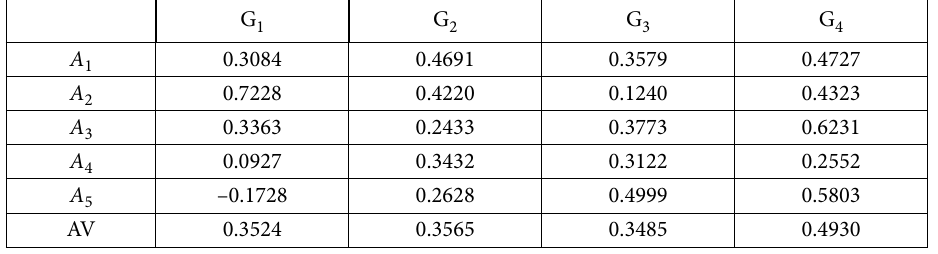
Table 5. The score values of ij ′δ and AV j